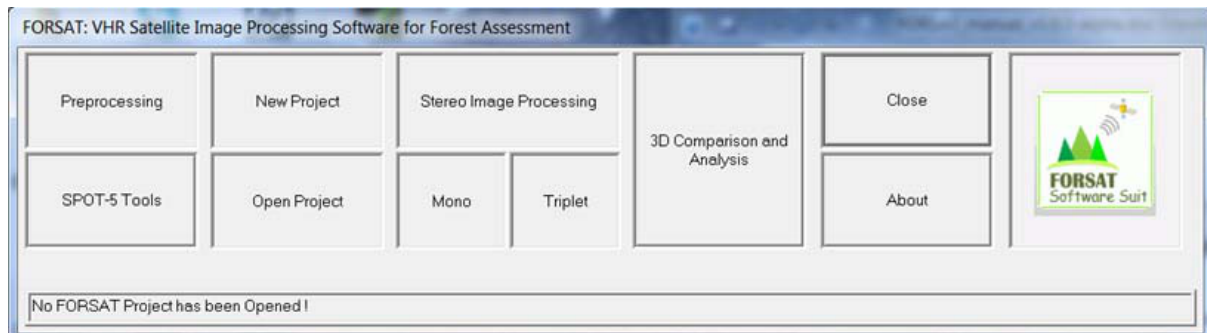
Figure 7. Graphical user interface of the FORSAT software